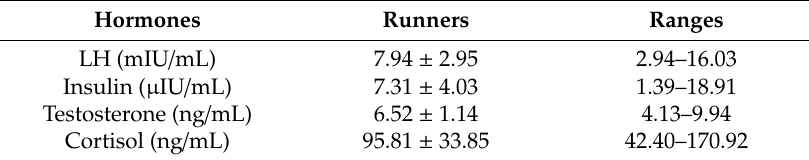
Table 4. Plasma hormonal concentrations in